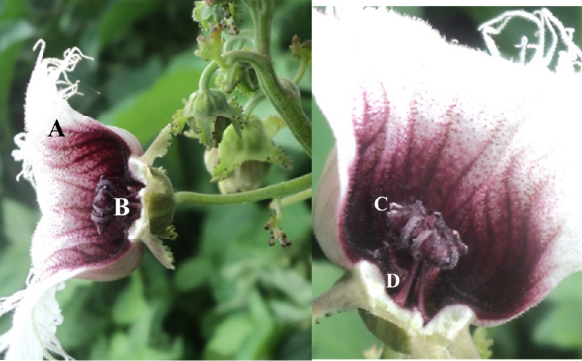
Fig. 2. 2. Male fluted pumpkin r Male fluted pumpkin raceme of staminate showing showing variation in color variation in color